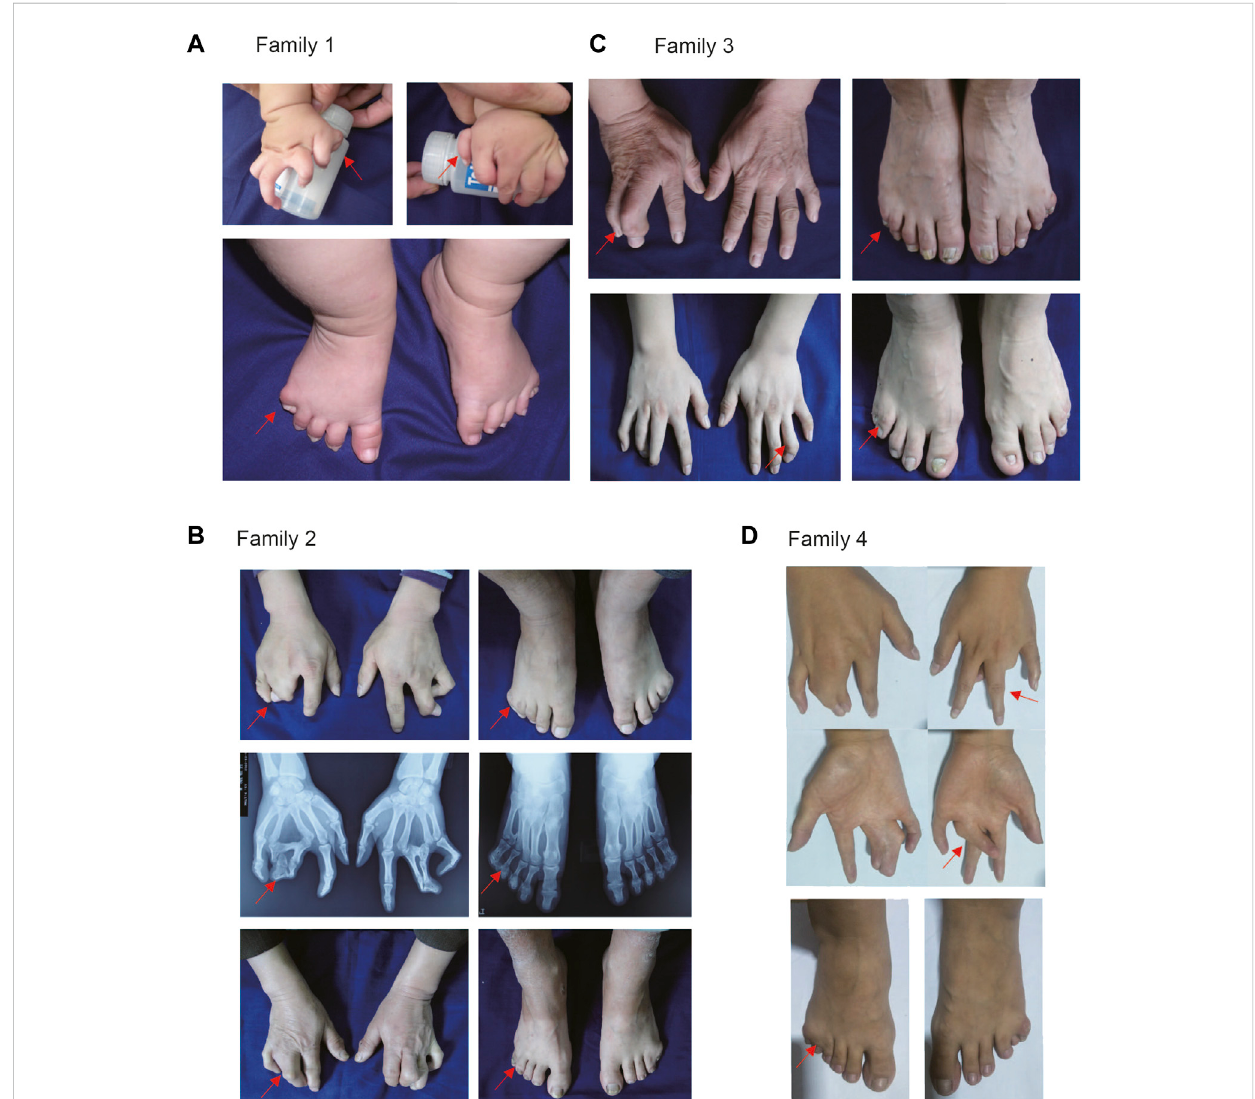
Clinical manifestation of patients with synpolydactyly. (A) Bilateral preaxial polydactyly of hands and postaxial synpolydactyly of feet found in a pediatric patient. (B) Bilateral or unilateral synpolydactyly in 3/4 fi ngers of the affected individuals in SPD families. (C) Congenital syndactyly between the 3/4 fi ngers. (D) There were syndactyly in the proband ’ s 3/4 fi ngers. The arrows indicate the patients ’ fi